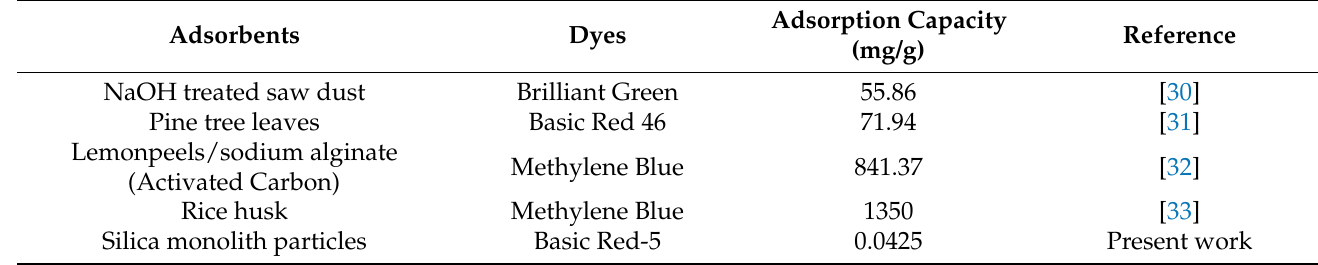
Table 6. Comparison of silica monolith particle adsorption capacity with other